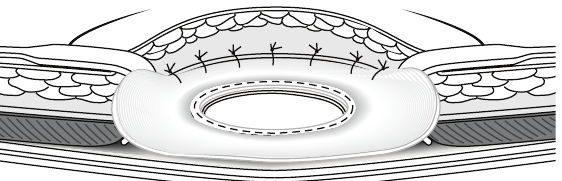
Figure 2: A mesh-reinforced stoma was constructed after the stapling device was fired and removed. The circumference of the mesh was sutured to the anterior rectus sheath. Reproduced with permission from Norman Williams ©